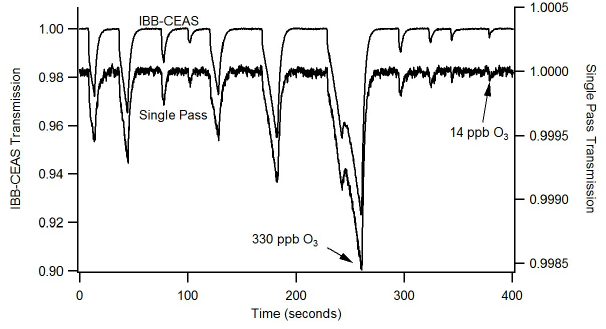
Fig. 4. Simultaneous 0.1s integration IBB-CEAS and single-pass transmission measurements of periodic ozone Figure 4. Simultaneous 0.1 second integration IBB-CEAS and single-pass transmission 3 measurements of periodic ozone introductions. 4